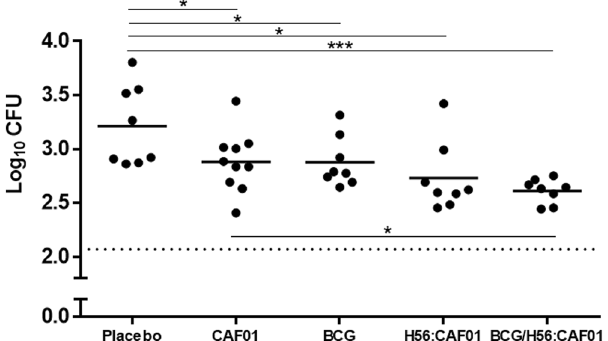
Figure 3. H56:CAF01 and BCG immunisation induced mycobacterial growth inhibition in murine splenocytes. Groups of mice were immunised three times s.c. with 2-week intervals with H56 in CAF01, H56:CAF01 SBS with BCG, adjuvant alone (CAF01) or Placebo (Tris buffer). At the same time as the first vaccination, a group of mice received a single dose BCG. Splenocytes were isolated one week after the last immunisation (5 weeks for BCG) and used in the MGIA. Solid lines represent the means of eight individual mice measured in duplicates (CAF01 n = 10). t-test, * p < 0.05; *** p < 0.001.